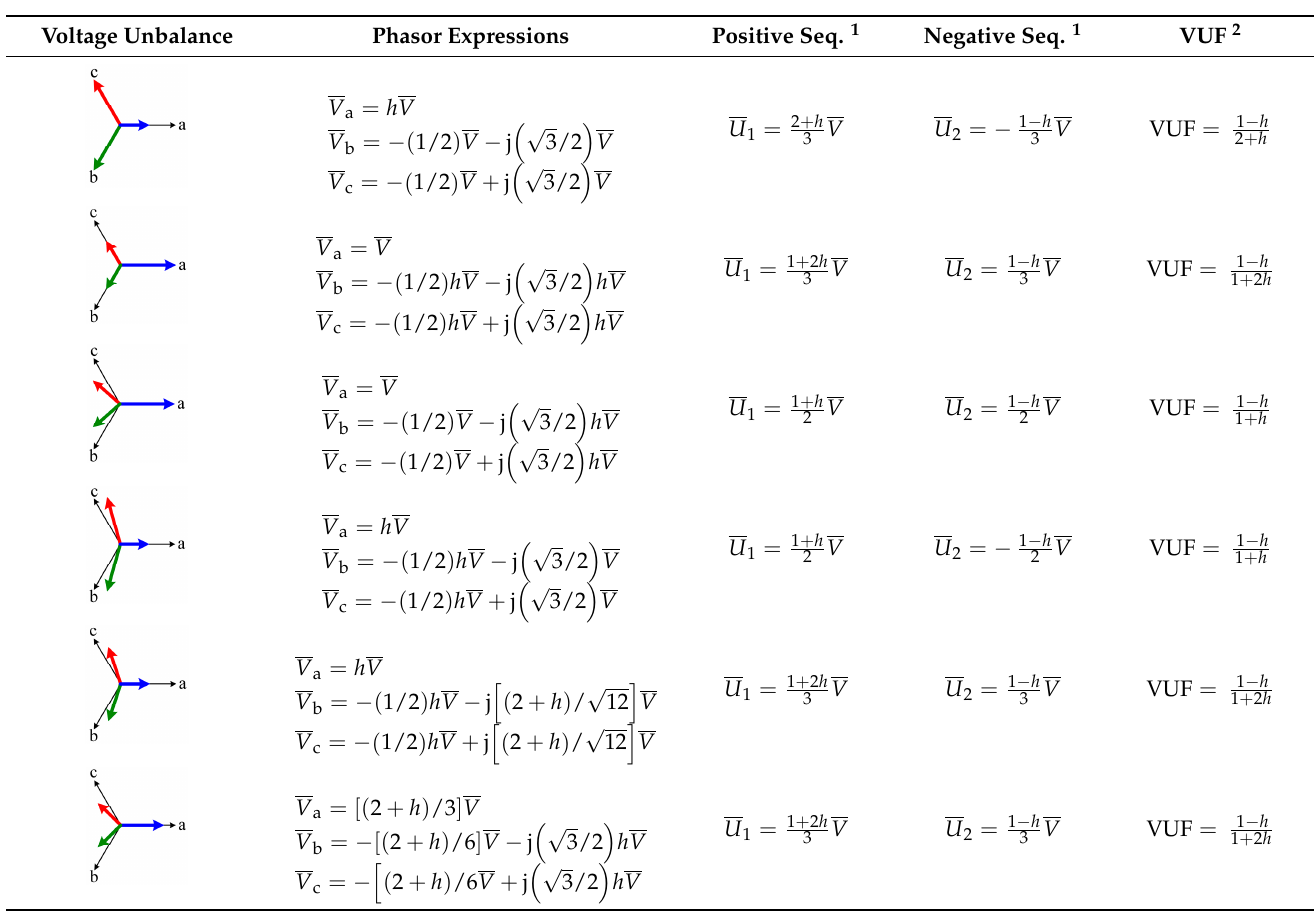
Table 1. Voltage unbalance quantification by using symmetrical